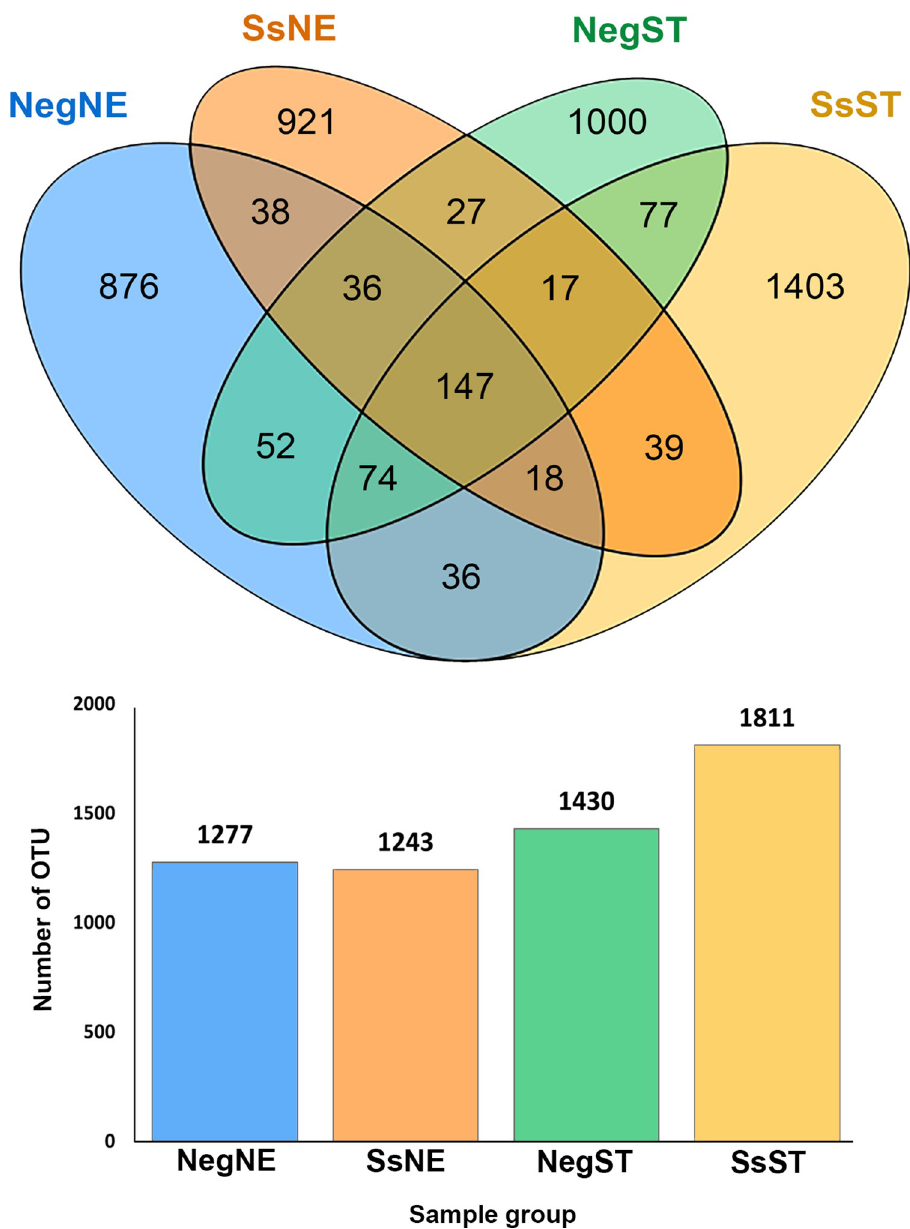
Fig 2. Venn diagram showing numbers of unique, shared and core bacterial OTUs among sample groups. Each ellipse represents one group. Values represent number of OTUs in each overlapping or unique segment. The lower panel graph represents total number of OTUs in each sample